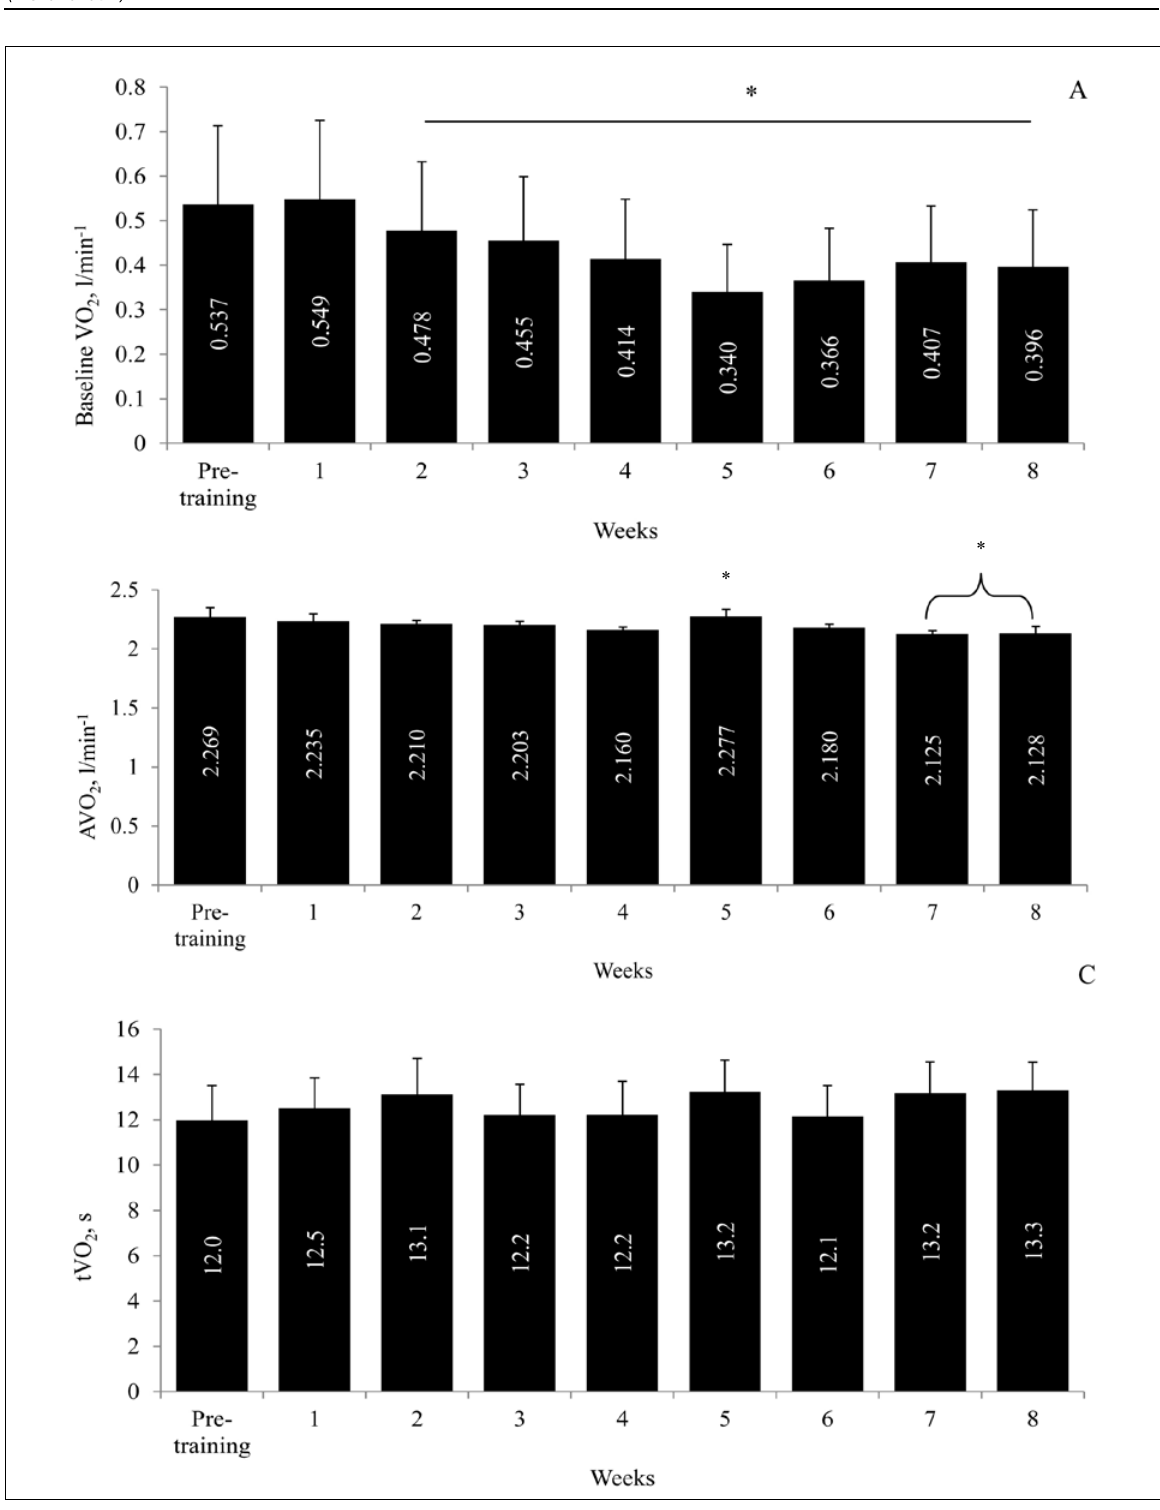
Figure 4. Baseline oxygen uptake (A), amplitude of oxygen uptake (B) and time constant of oxygen uptake (C) mean values every week during interval endurance